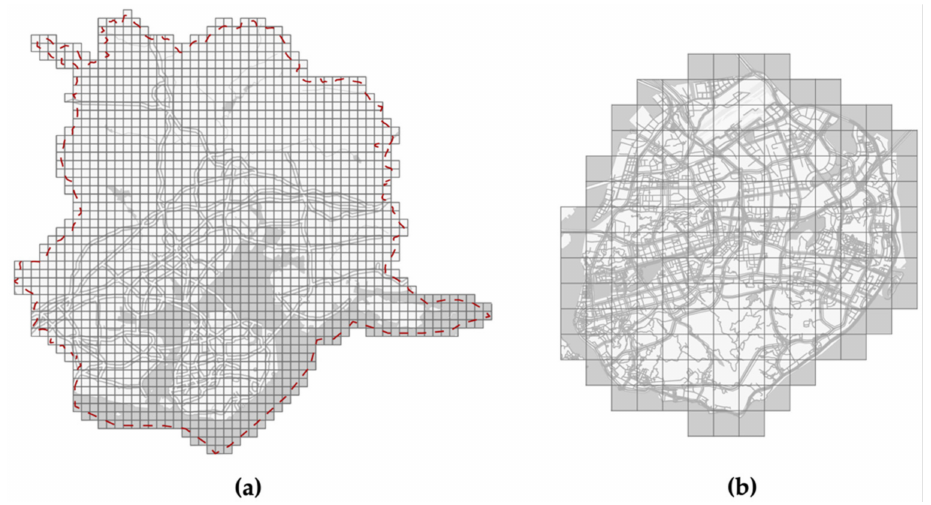
Figure 3. Uniform cell partition: ( a ) study area and cell partition; ( b ) close shot at the Xiamen Island.